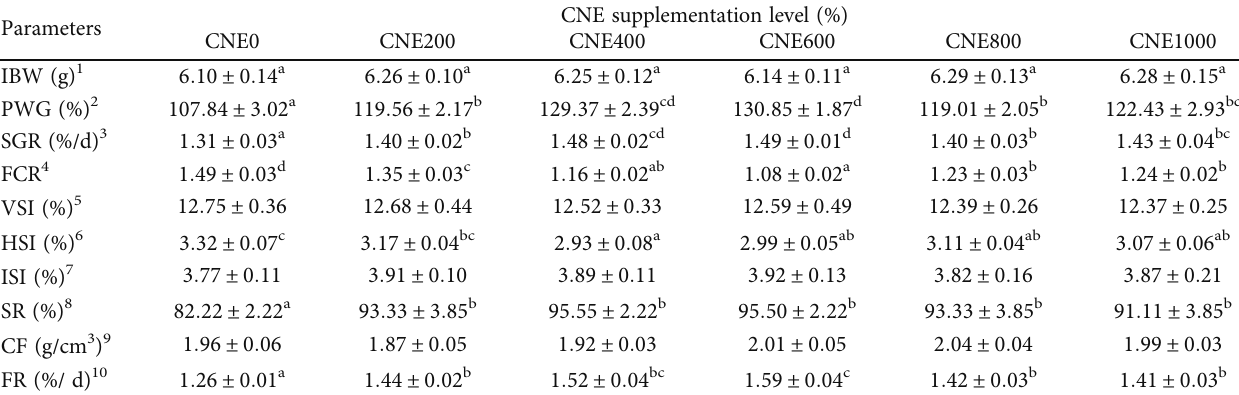
Table 3: Growth performance and feed utilization of juvenile H . otakii fed the experimental diets for 8 weeks. Parameters